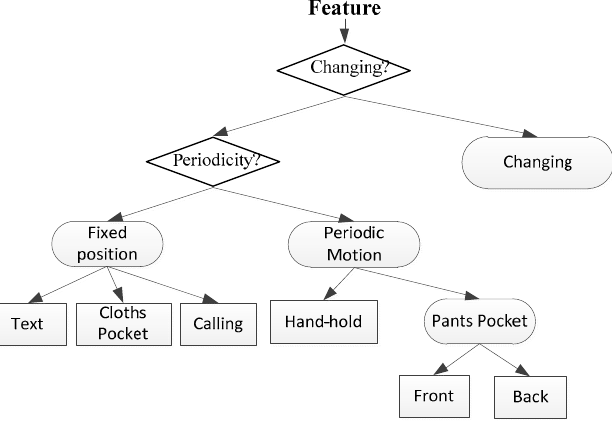
Figure 1. The example of decision tree for smartphone modes recognition.